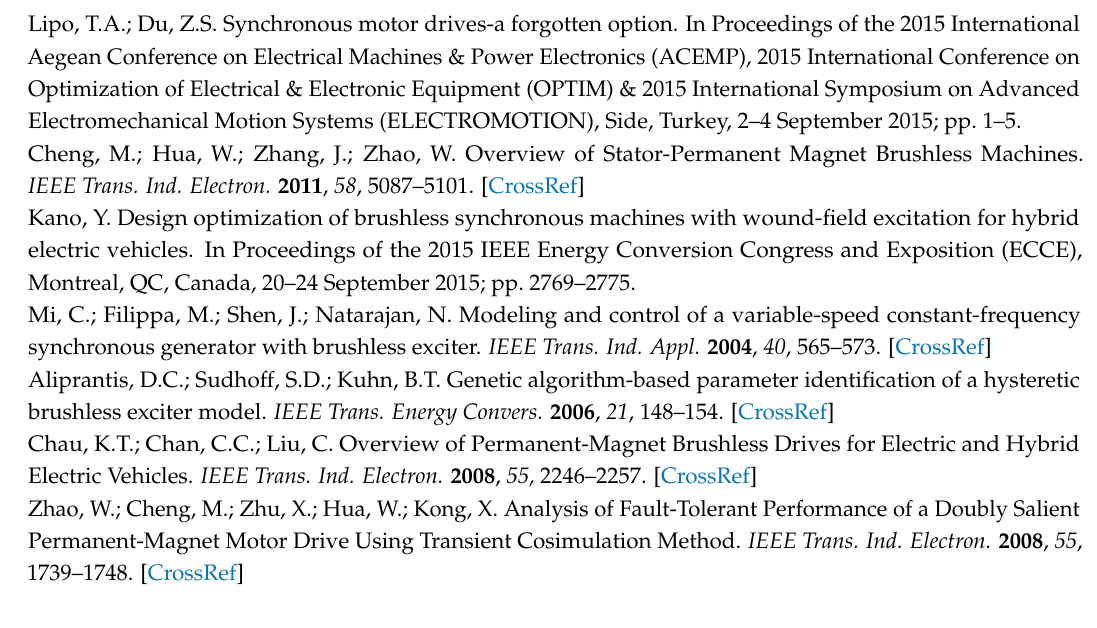
Figure 21. Experimental analysis: torque at synchronous speed.